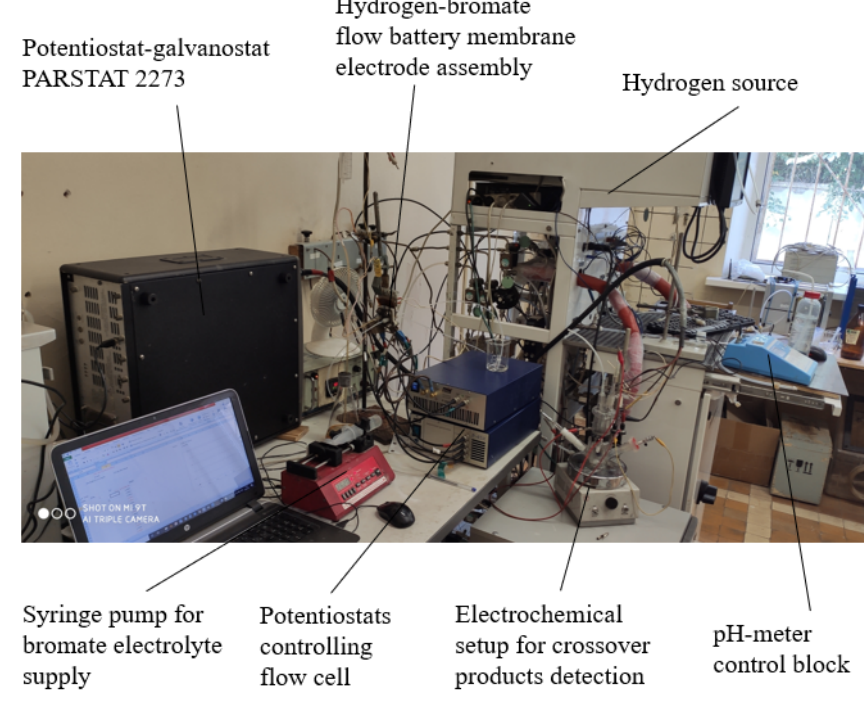
Figure 2. The overall experimental setup for the hydrogen − bromate flow battery study.